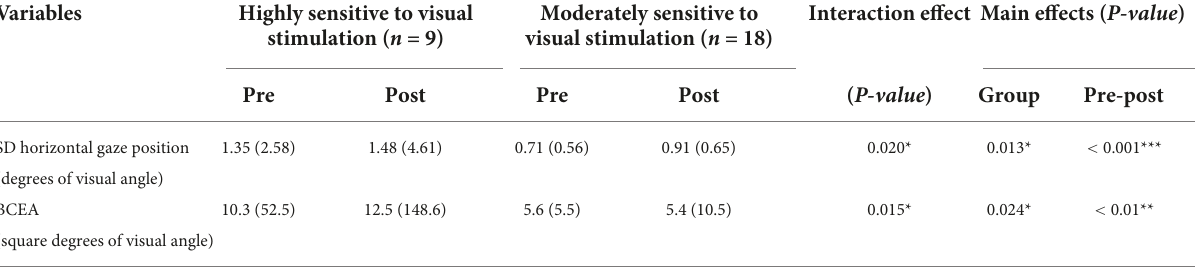
TABLE 3 Comparisons of the standard deviation of the horizontal gaze position and bivariate contour ellipse area in the pre-stimulus and post-stimulus states between the highly and moderately sensitive to visual stimulation groups. Variables Highly sensitive to visual Moderately sensitive to Interaction effect Main effects ( P-value ) stimulation ( n = 9) visual stimulation ( n = 18) Pre Post Pre Post ( P-value ) Group